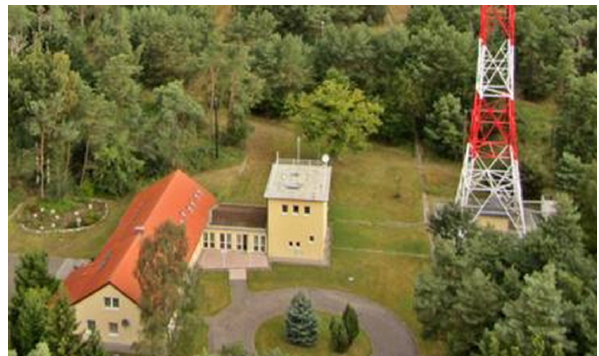
Figure 47. Juliusruh Station today.